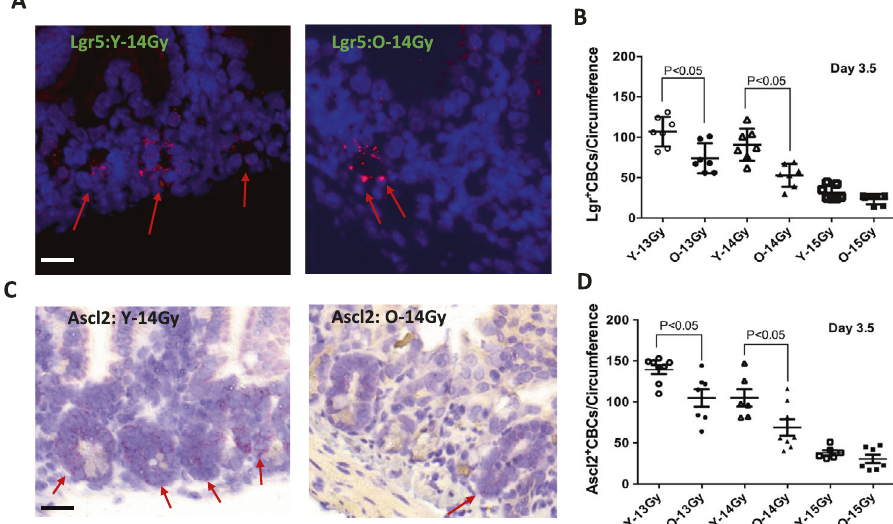
Fig. 3 Quanti fi cation of CBC per jejunum circumference at 3.5 days post subtotal RT. Red arrows indicate the positive staining of Lgr5 in- situ hybridization staining fl uorescence (Upper left & center, 40X magni fi cation) andAscl2 in-situ hybridization bright fi eld (Lower left & center, 40X magni fi cation). A Representative images of data of Lgr5 positive CBC per circumference young (upper left panel) and older mice (upper center panel). B Quanti fi cation of Lgr5 positive per jejuna circumference. Lgr5 positive CBC are presented as means ± SD. N = 3 mice/group, 10 circumferences per mouse. C Representative images of Ascl2 positive CBC per jejuna circumference young (bottom left panel) and older positive Ascl2 per circumference (bottom center panel). D Quanti fi cation of Ascl2 positive CBC per jejuna circumference. * P < 0.05 Y-13Gy vs O-13 Gy and Y-14 Gy vs O-14 Gy, Student ’ s t -test.Scale bar 20 μ